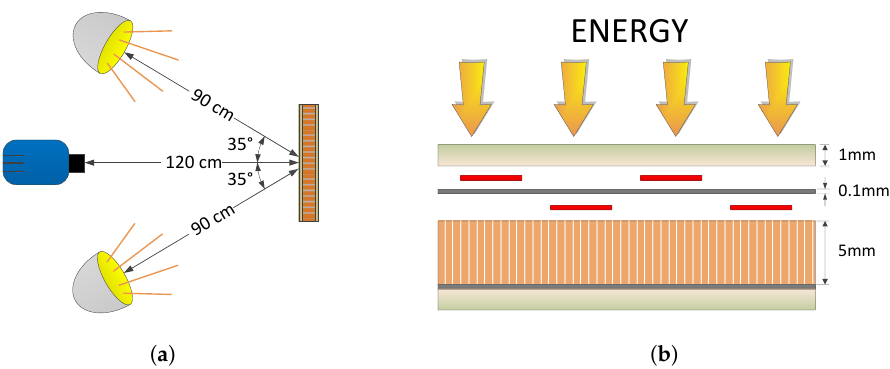
Figure 5. Experimental NDT thermographic inspections: ( a ) setup of the laboratory tests, ( b ) depth of defects in the inspected